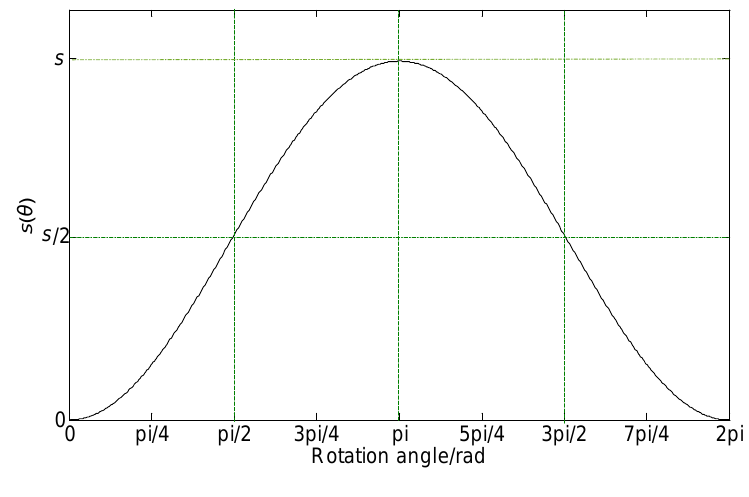
Figure 2. The variation of s ( θ ).